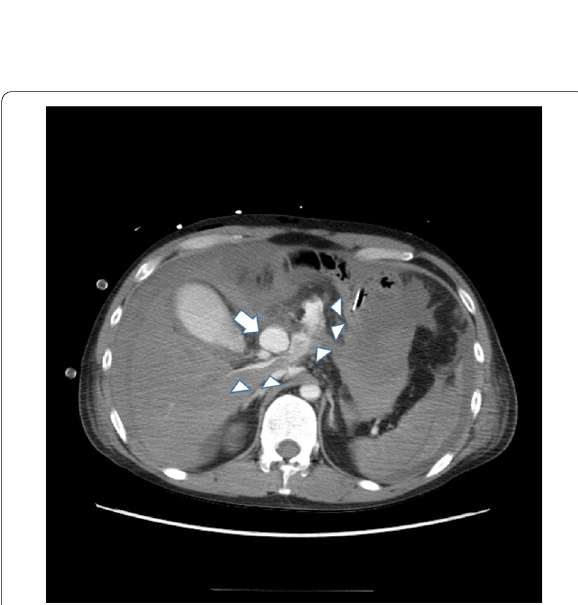
Fig. 4 Abdominal computed tomography findings on the fifth day after surgical sigmoid colon resection and colostomy construction. An aneurysm in the common hepatic artery (white arrow) and extravasation (white triangles) are